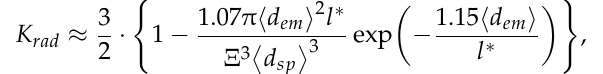
Figure 6. The wavelength-averaged cross sections of the stimulated emission (cid:104) σ st (cid:105) molecules against the pump intensity. 1—R6G molecules, 2—DCM molecules. Selectively shown error bars correspond to a confidence level of 0.9. Vertical dashed lines correspond to the random lasing thresholds for the samples #1.